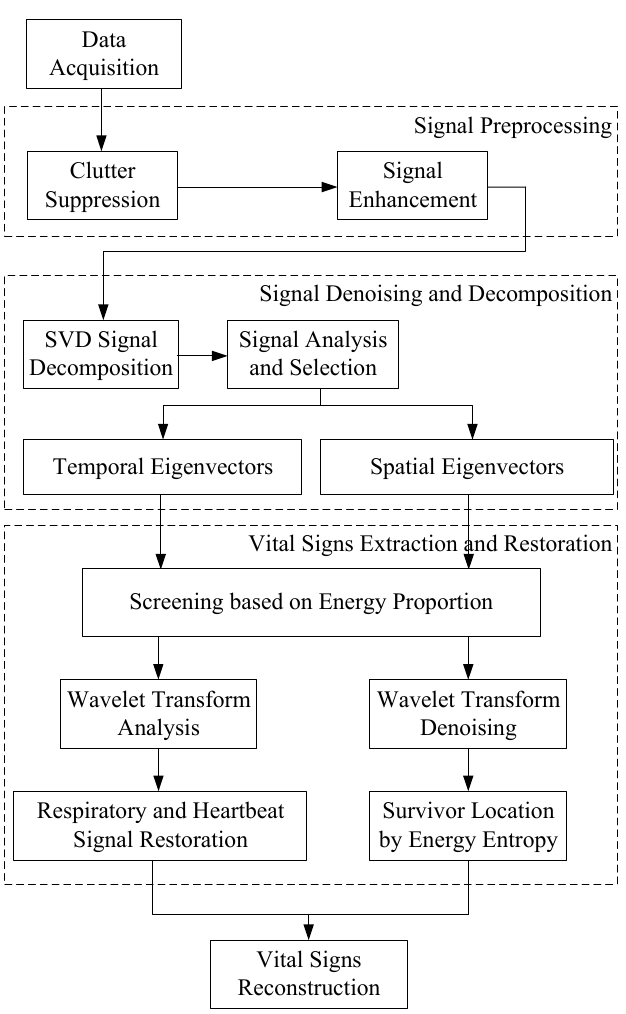
Figure 4. Specific flowchart of proposed